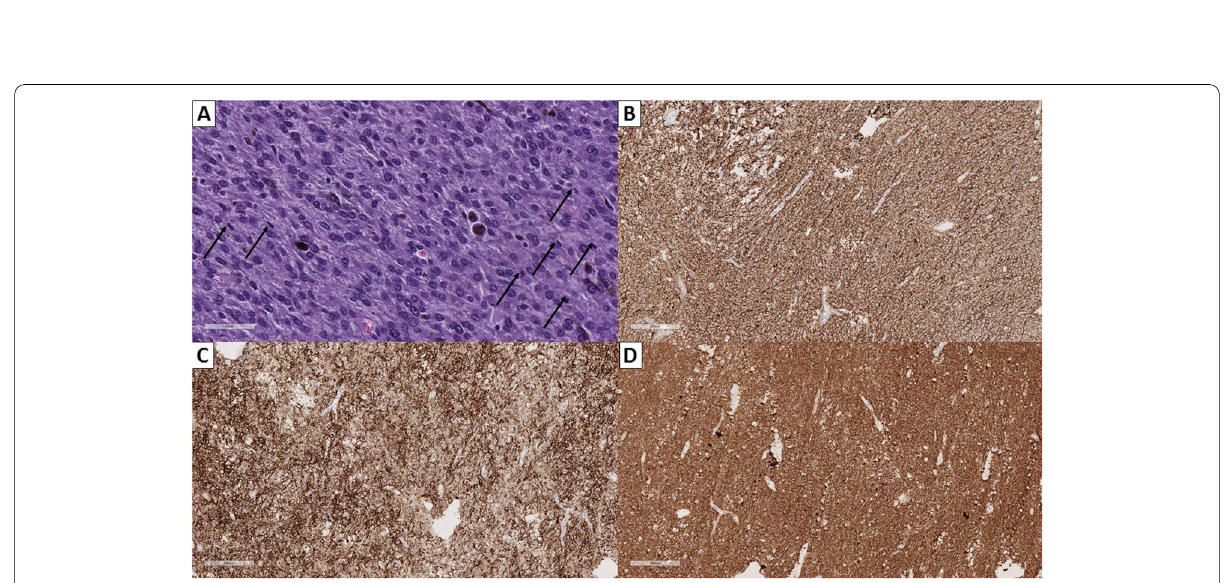
Fig. 6 A Multiple mitotic figures (arrows), hematoxylin and eosin stain, original magnification 400 original magnification 100